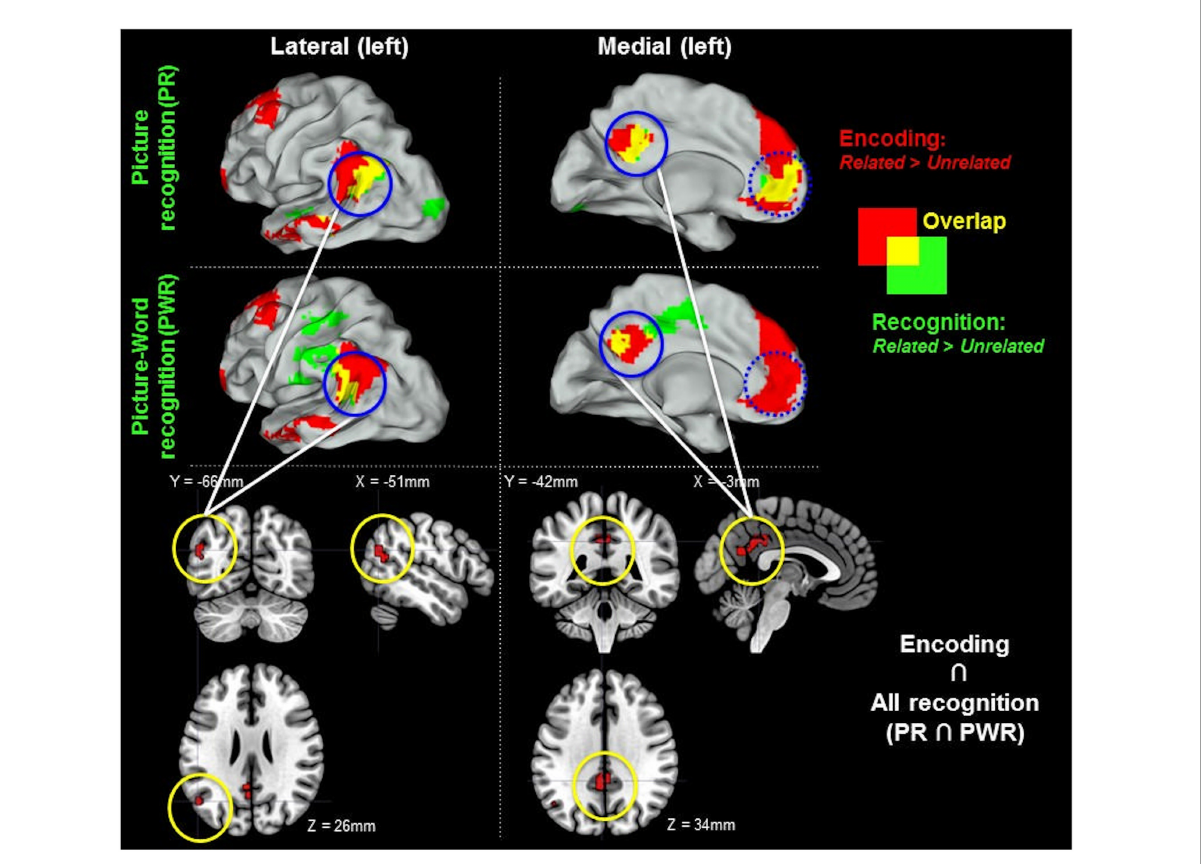
FIGURE7 Related > Unrelated during encoding and recognition. Regions with increased activity for Related > Unrelated at encoding are shown in red in the upper two rows. Recognition-related activity increases for (Old) Related > (Old) Unrelated are shown in green: (i) for picture recognition (PR) in the first row and (ii) for picture-word recognition (PWR) in the middle row. The overlap between encoding and recognition-related activity is indicated in yellow. Solid blue circles indicate regions of activity overlaps between encoding and all recognition (encoding ∩ PR ∩ PWR). The shared overlaps are shown in sectional views in the bottom row. Dotted blue circles indicate overlaps between encoding and either PR or PWR but not both. There was no overlap in the right hemisphere. The figure shows clusters whose peak survived a size-threshold for p < 0.05 FWE-corrected (cluster-forming threshold at p < 0.001